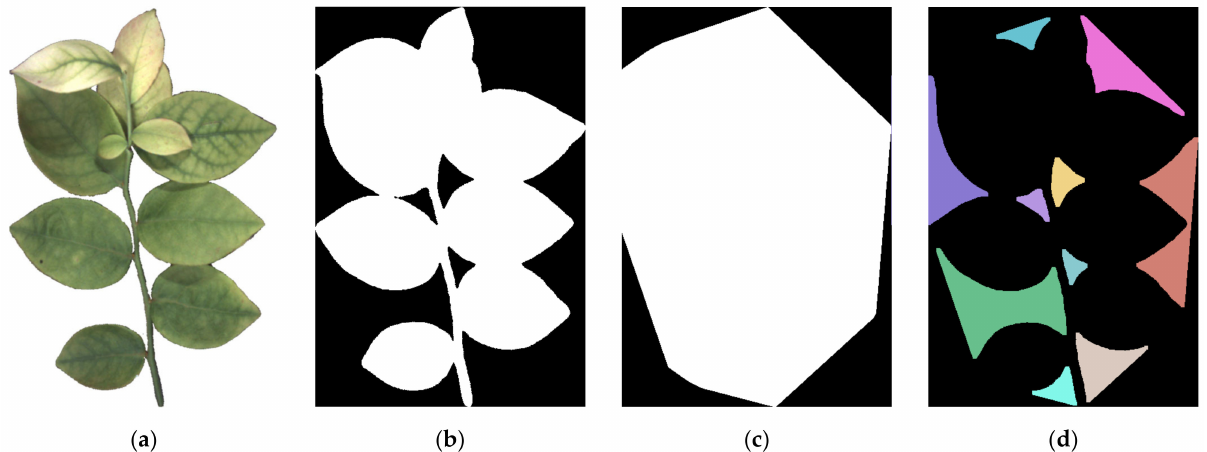
Figure 7. RoIs segmentation pipeline. ( a ) Segmented plant cutting extracted from an original RGB image. ( b ) Segmented plant cutting’s mask after preprocessing. ( c ) Convex hull mask. ( d ) RoIs mask where each color represents one